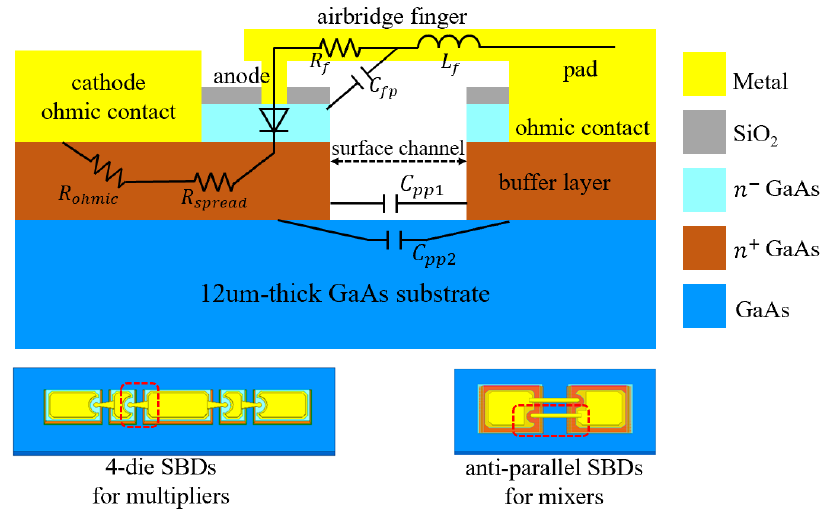
Figure 1. The cross-sectional view of the planar Schottky diode and a simplified equivalent circuit